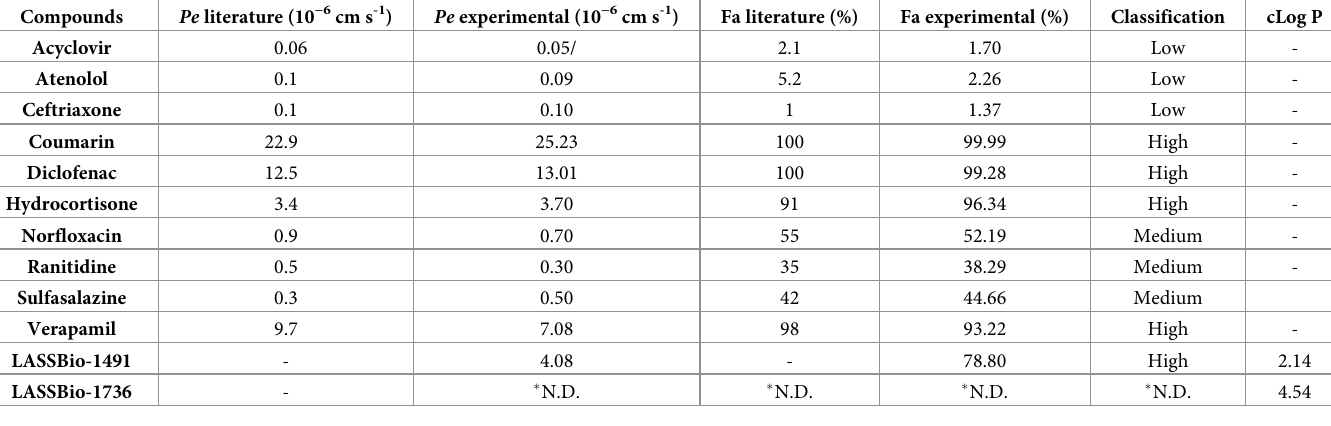
Table 2. Permeability coefficient of standard drugs and LASSBio-1491 determined by GIT-PAMPA assay. Compounds Pe literature (10 − 6 cm s -1 ) Atenolol